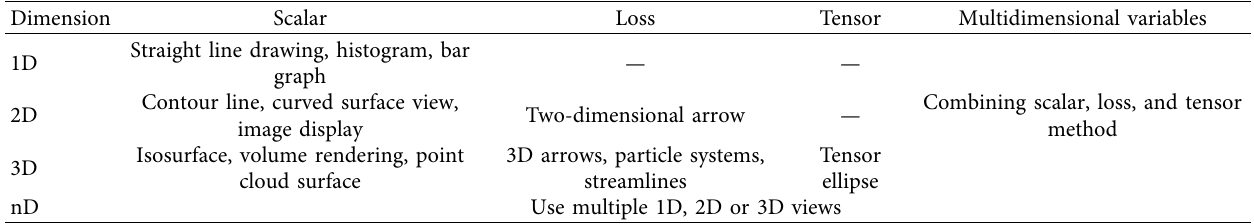
Table 2: Typical technology of visualization